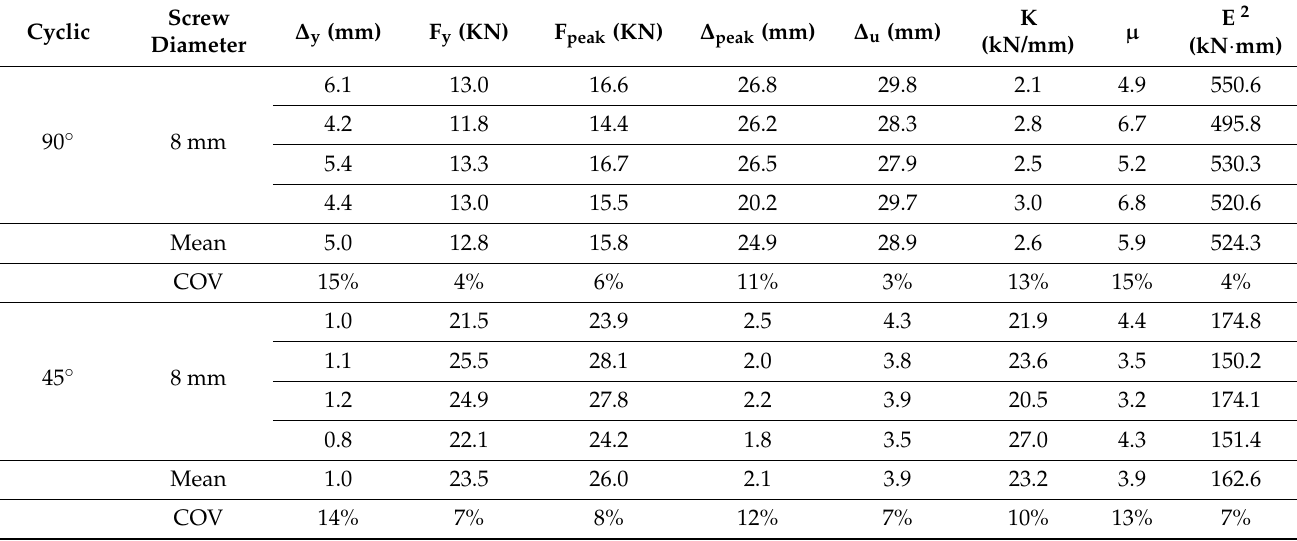
Table 4. Mechanical properties of STS connections under reversed-cyclic